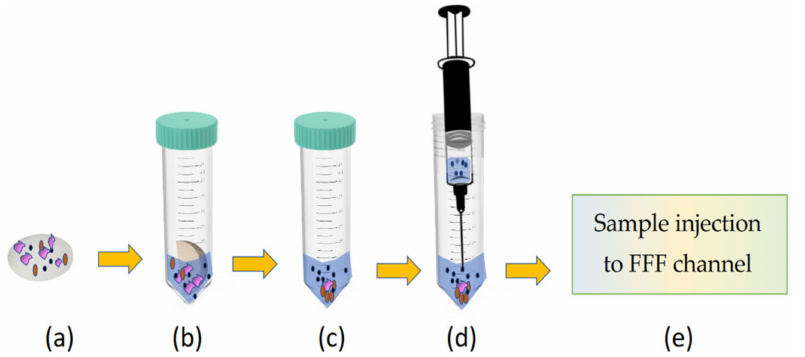
Figure 1. Isolation of RCMD particles. ( a ) Filter paper containing the RCMD particles was placed in 2 mL of the carrier fluid, ( b ) mixed by a vortex mixer followed by 3 bath sonication treatments every 24 h. ( c ) The suspension was settled for two hours to exclude the fraction over 1 micron in diameter. ( d ) A total of 100 µ L of the sample was drawn from the top 0.5 cm using a micro syringe, ( e ) the sample was injected to the FFF channel for size